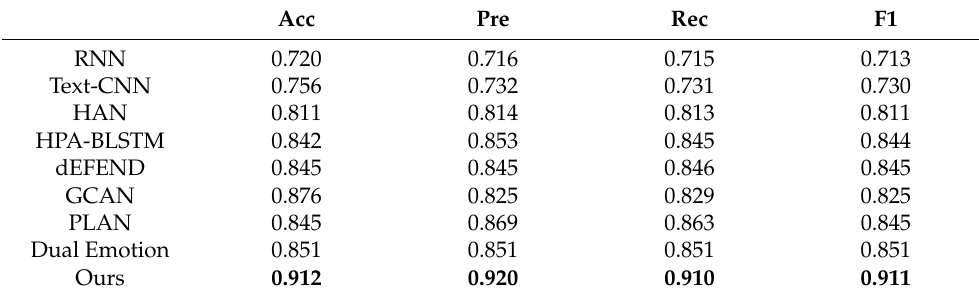
Table 2. Performance comparison between the state-of-the-art models and our model on twitter15.